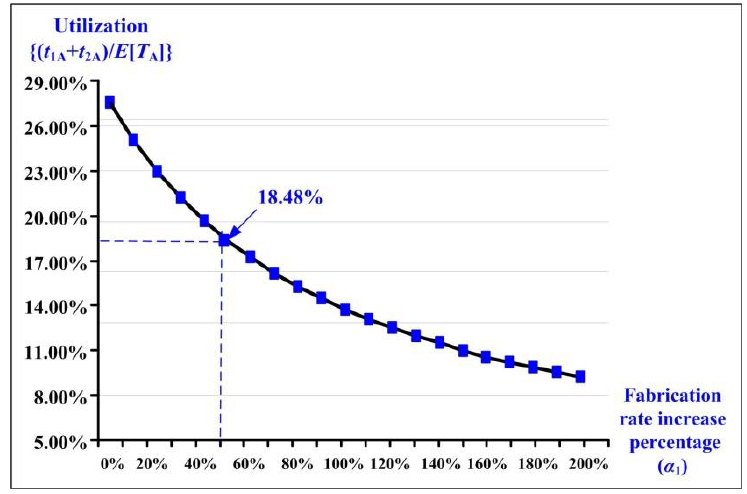
Figure 7. Fabrication rate increase percentage effects on the machine utilization